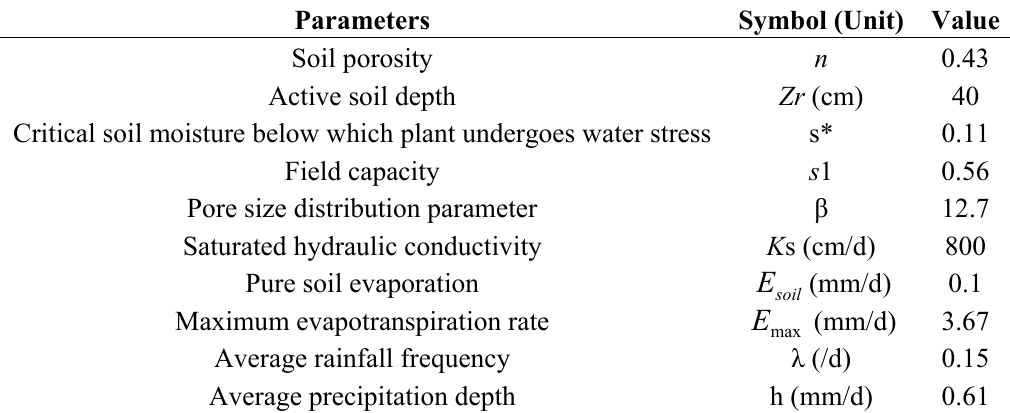
Table A3. Parameters of the simplified ecohydrological box